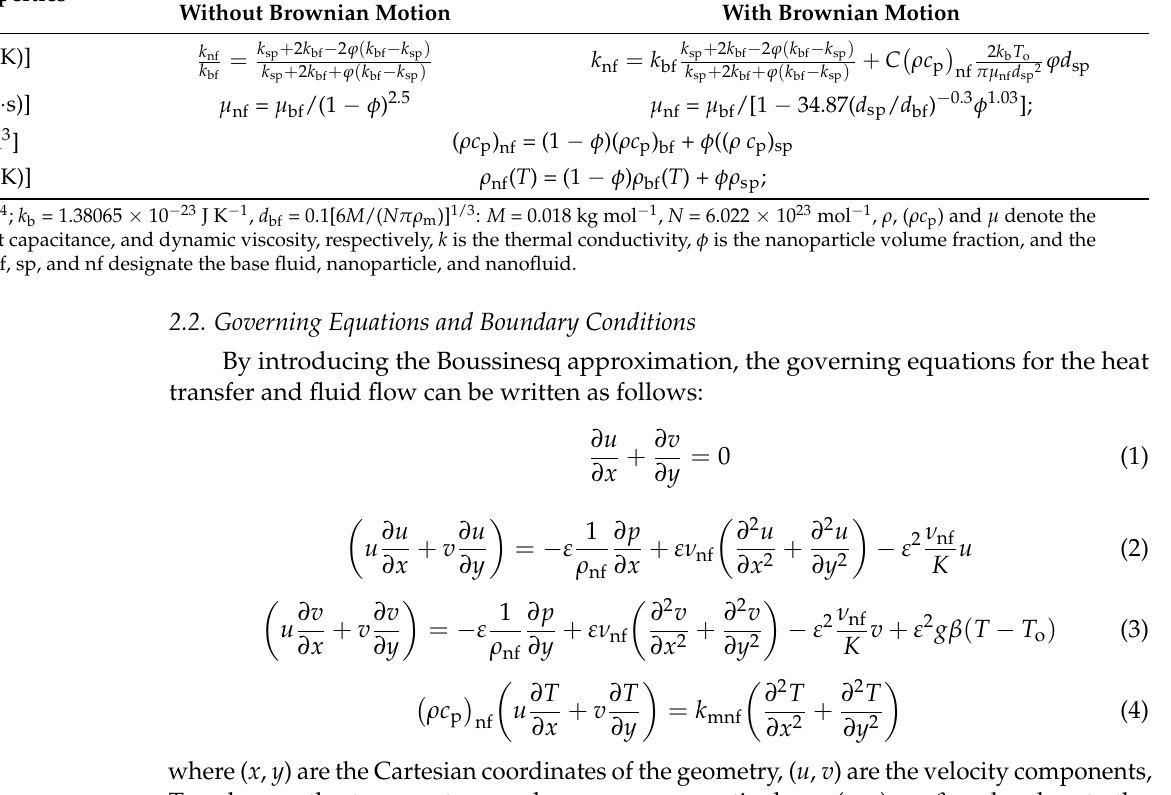
Table 2. Applied models for thermophysical properties of the nanofluid with or without Brownian motion. Physical